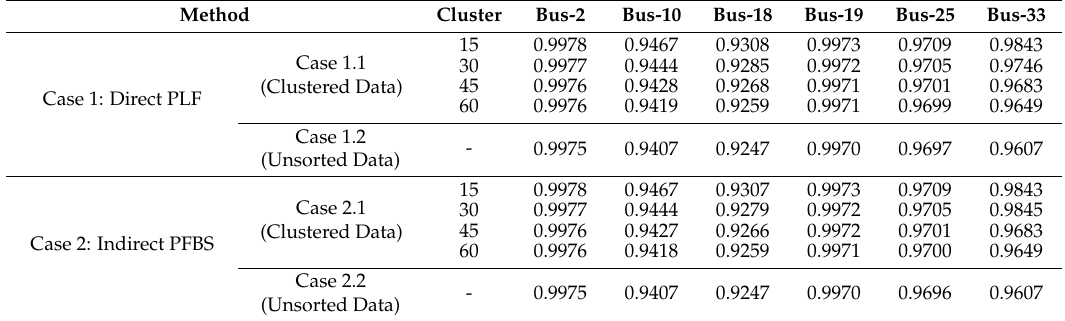
forward/backward sweep (PFBS) methods. Table 2. Comparison between the proposed direct PLF and the indirect probabilistic